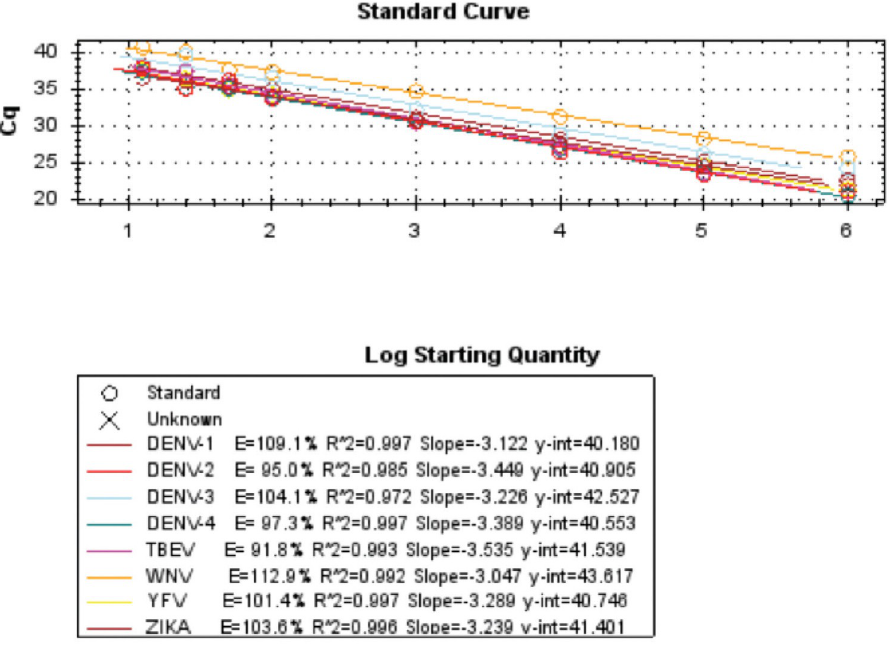
Fig 4. Results obtained using the pan-flavivirus assay (Cycle threshold (Ct) from a single PCR replicate). The standard curve was plotted using the log10 concentration versus Ct value.